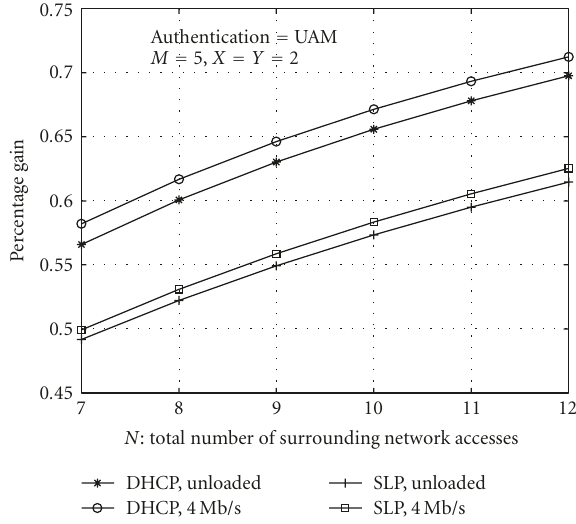
Figure 15: Percentage gain versus N : MAC-based authentication.